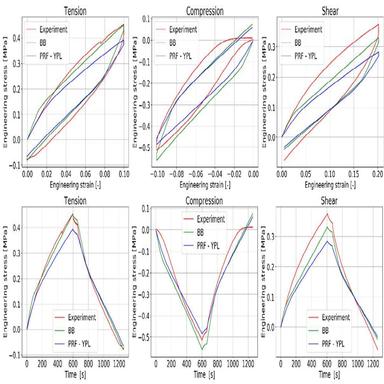
omparison of experimental and predicted curves for strain rate 0.01 s-1.